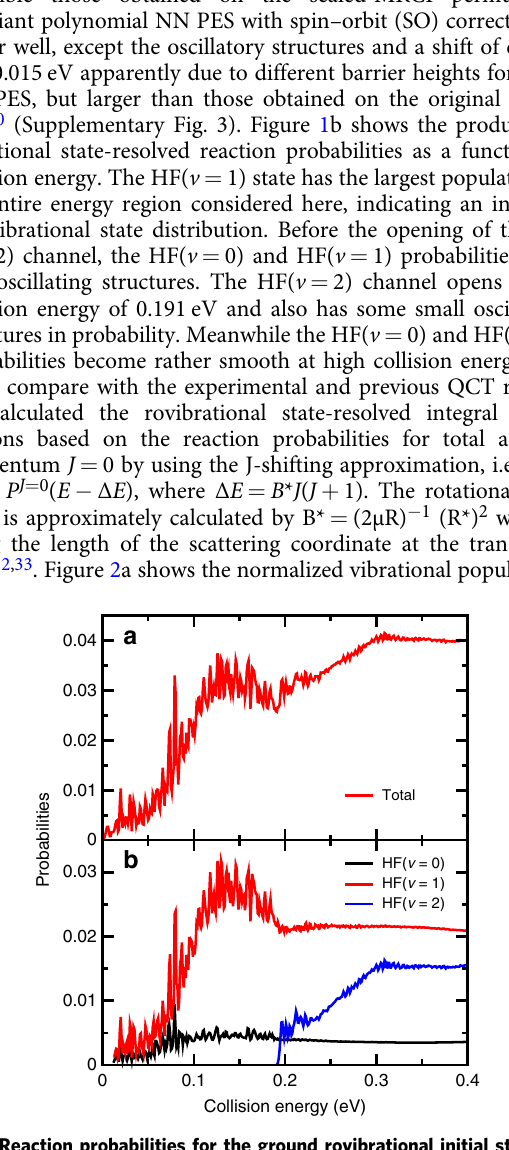
Fig. 1 Reaction probabilities for the ground rovibrational initial state. a Total and b product HF vibrational state-resolved reaction probabilities as a function of collision